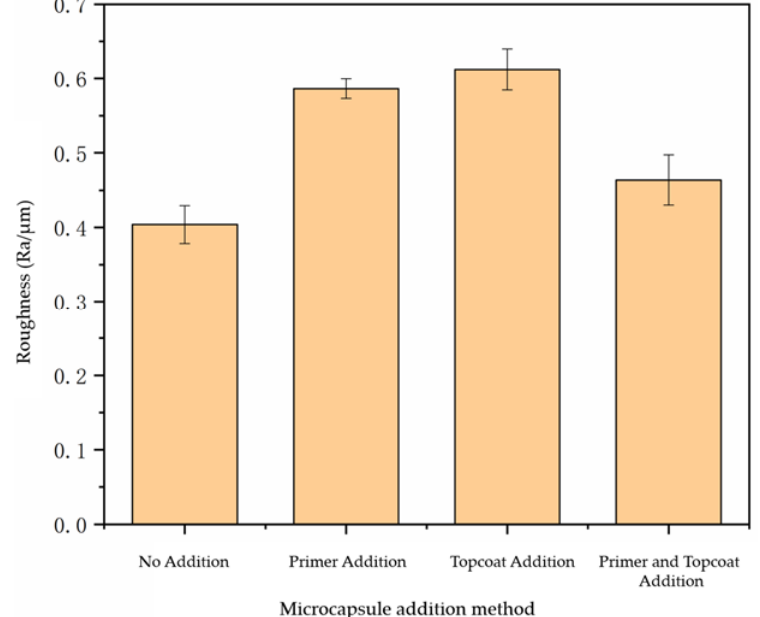
Figure 5. Influence of addition methods on the roughness of paint film.